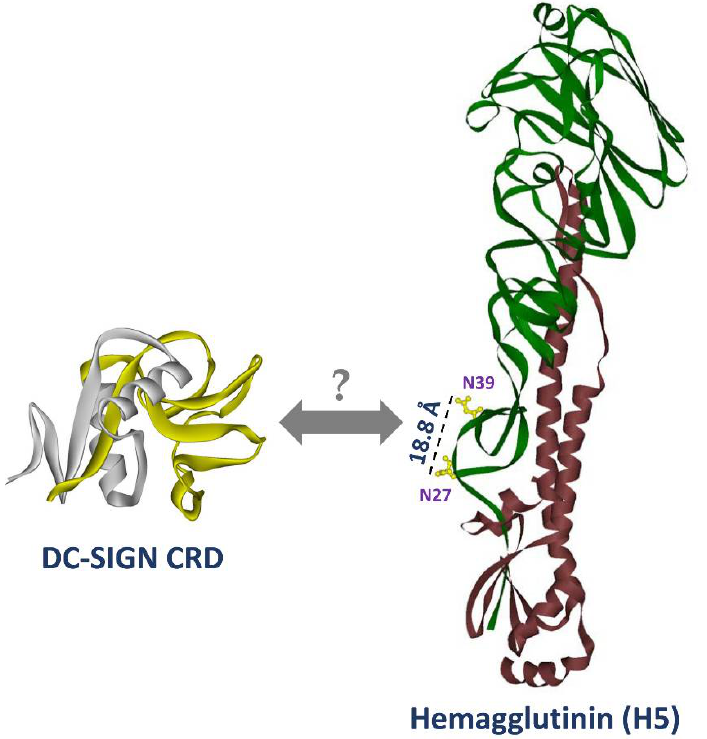
Figure 8. The scheme of the structure DC-SIGN carbohydrate recognition domain (CRD) lectin- interacting domain and two essential N-glycosylation sites shown on H5N1 hemagglutinin protein. The lectin-interacting domain of DC-SIGN CRD and N27 and N39 N-glycosylation sites on H5N1 hemagglutinin structure is demonstrated. The distance between N27 and N39 was measured using DS Viewer program. The yellow labeling structure in DC-SIGN CRD (PDB 1XAR) indicates lectin-binding domain according to the reference published elsewhere [52]. The green and red labeling structures of hemagglutinin indicate HA1 and HA2, respectively (PDB 2FK0). The DC-SIGN CRD and H5 structures of this figure were manually superimposed instead of showing the co-crystal structure results.